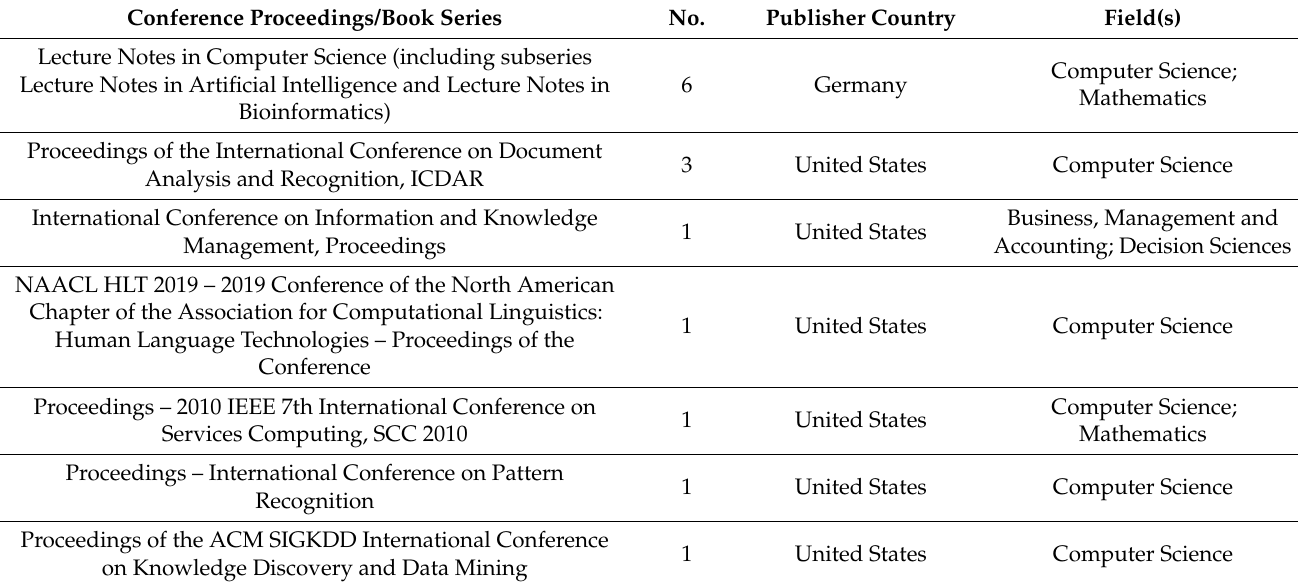
Table 2. Publication sources of the selected conference